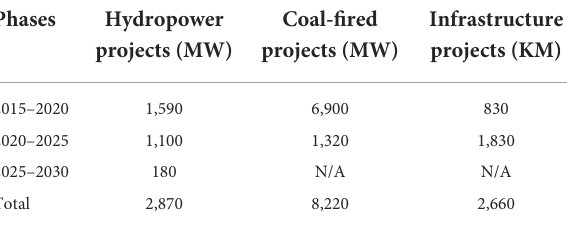
TABLE 2 Planned projects in the